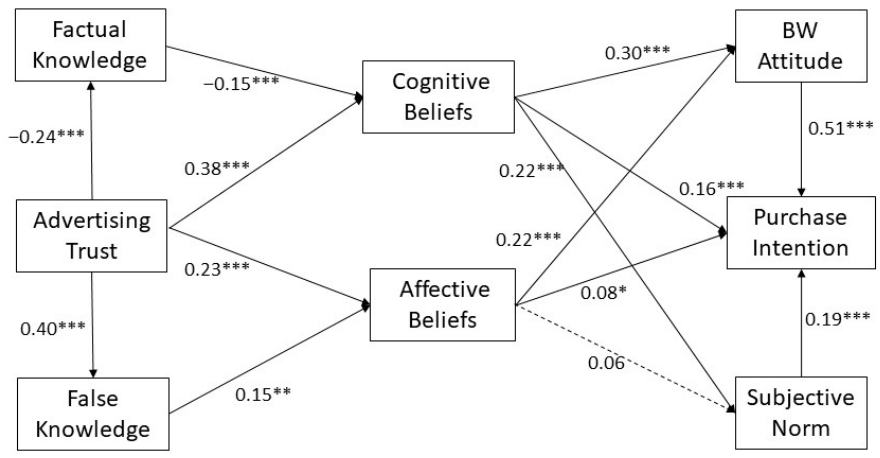
Figure 2. Path Model Results. * p < 0.05, ** p < 0.01, *** p < 0.001.